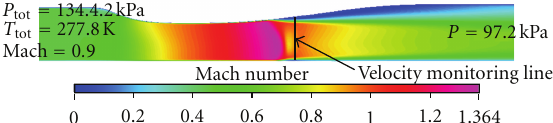
P tot = 134.4.2 kPa T tot = 277.8 K